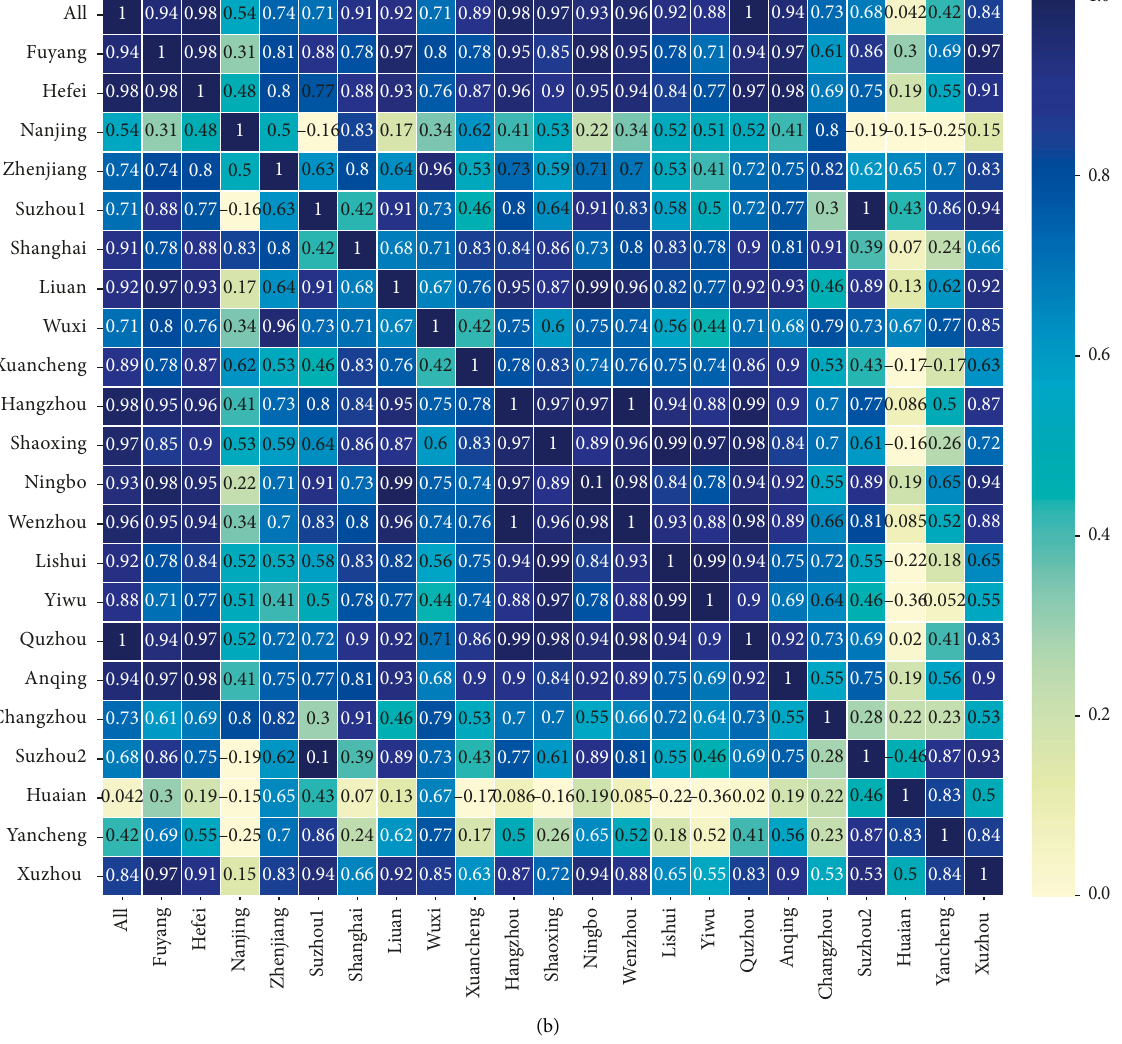
Figure 13: Matrix diagram of relevance coefficient of corporate development of cities in the (a) five years before 2013 and the (b) five years after